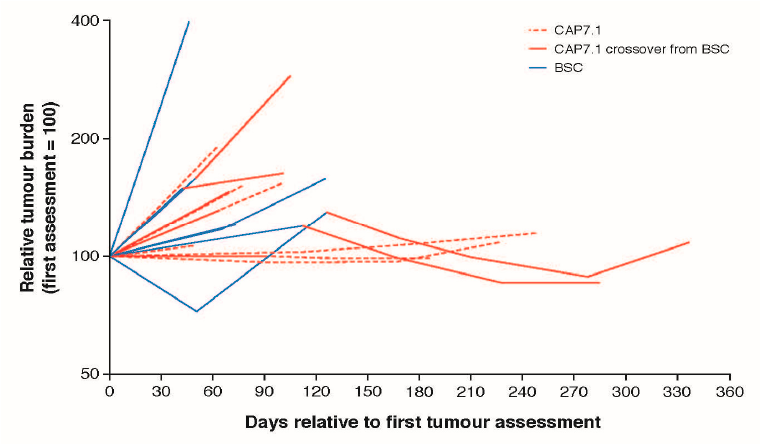
Figure 3. Tumour burden trajectories for 19 patients with at least 2 assessments in the FAS population.